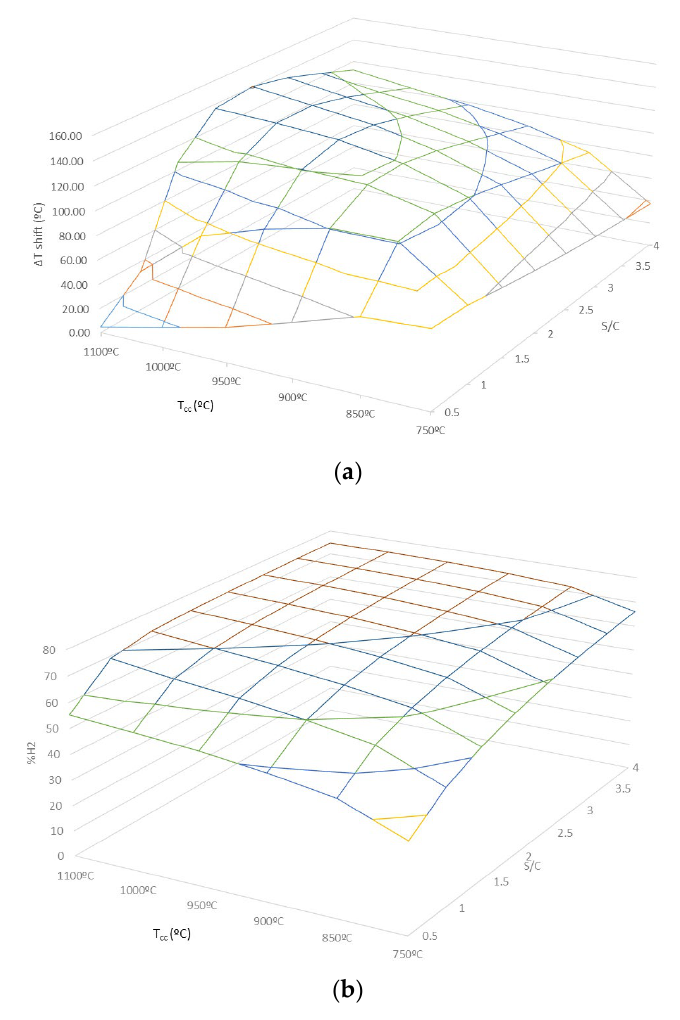
Figure 3. ( a ) Evolution of Δ T shift (°C) for T cc and S/C molar ratio and ( b ) profile of % H 2 for T cc values and S/C molar ratio.